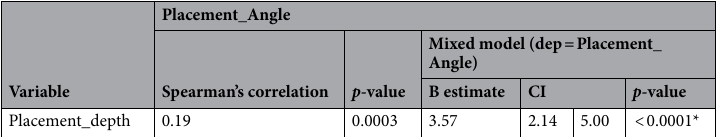
Table 4. Correlation of placement angle and placement depth. * p <